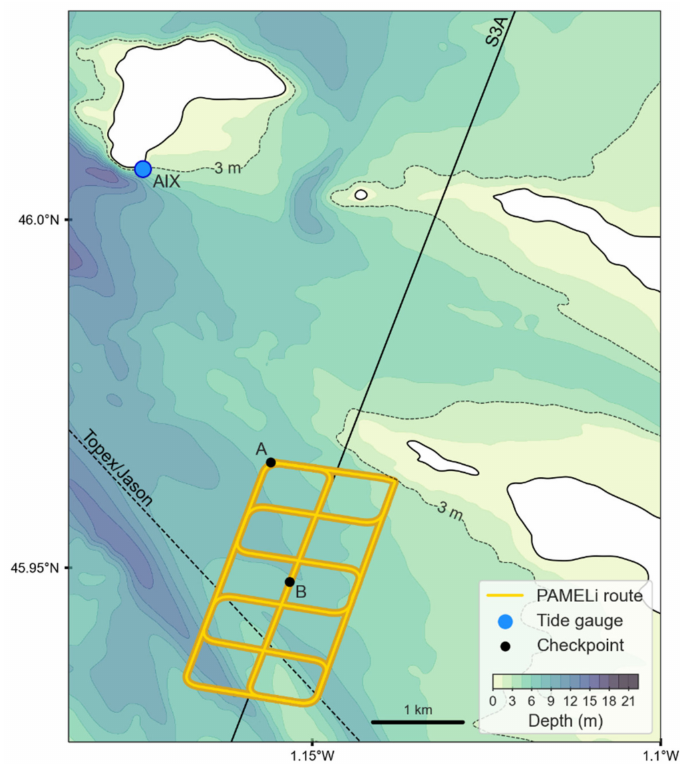
Figure 3. PAMELi repeated survey during the two days campaign (yellow line). TP/Jason (dashed) and S3A (plain) nominal tracks are indicated by the grey straight lines. Aix island tide gauge (AIX) is represented by a blue circle. A and B black dots represent the starting point of the repeated survey and a reference point located at the middle of the survey extent, respectively. The grey contour is the 3 m isobath in the area.